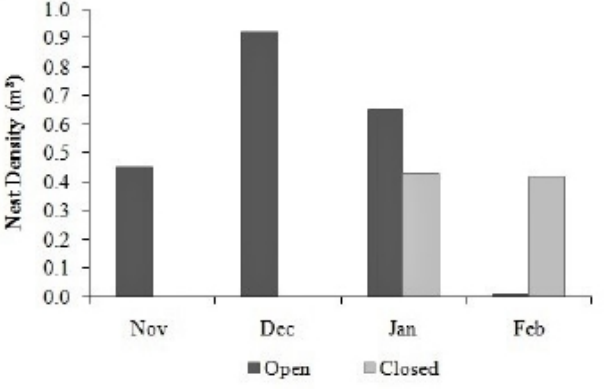
Fig 2. Density (nests/m 2 ) of open (in activity) and closed nests per month in an aggregation of Epicharis dejeanii on Ilha do Superagui (IS) during the warm-wet season, when the nests are constructed, showing data of November 2015 (N =29), January 2016 (N = 70), February 2016 (N = 28) and December 2016 (N = 59). The representation of density of the open nests in December 2016 is shown in different color (dark gray) to highlight that the nests from this month were surveyed in the following reproductive